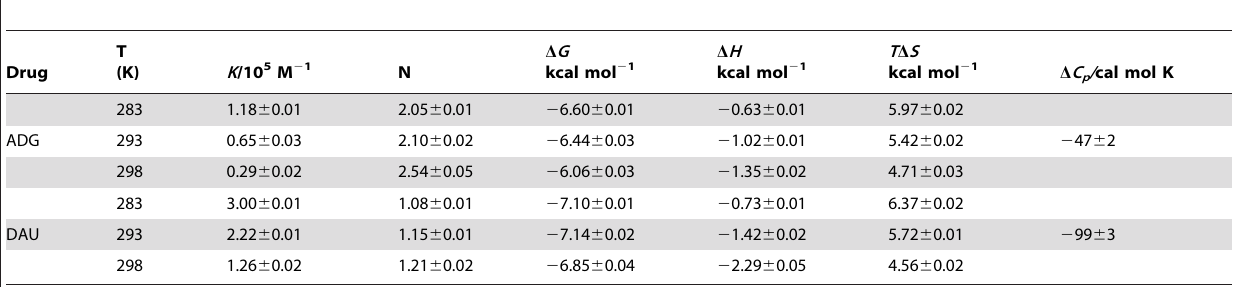
Table 3. ITC derived thermodynamic profiles for the binding of ADG and DAU to tRNA at different temperatures in CP buffer 20 mM [Na + ].